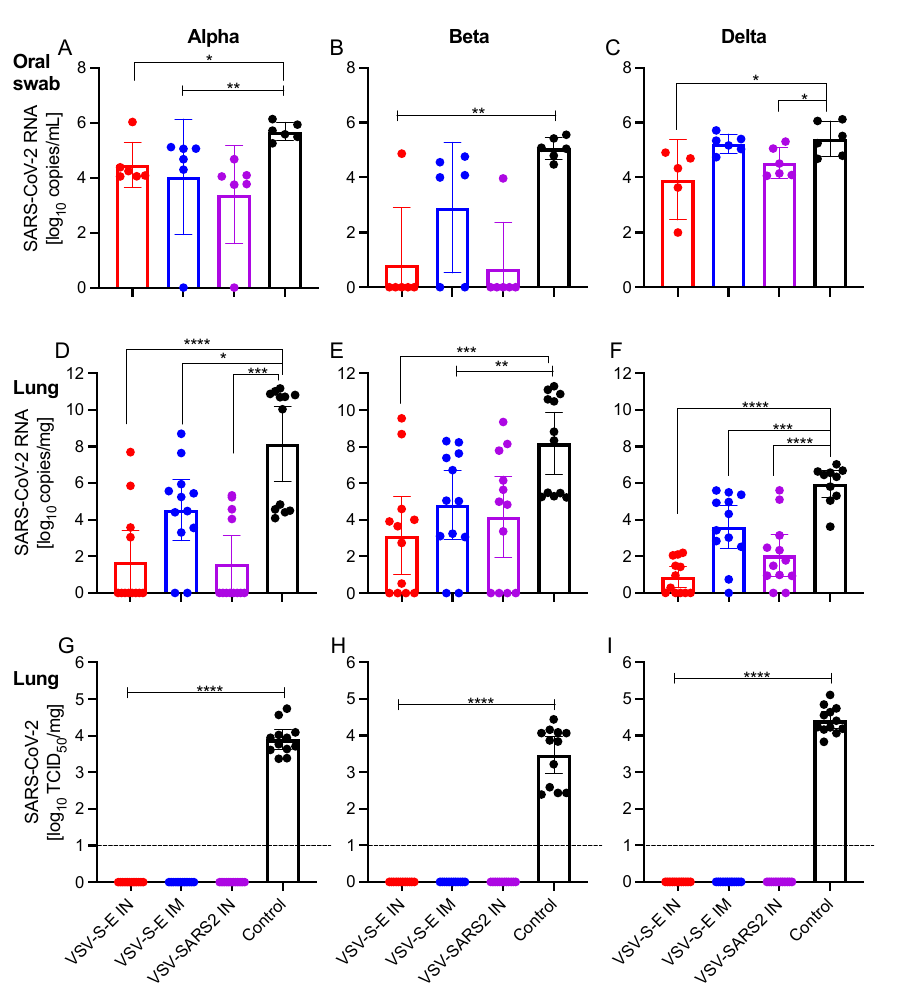
Figure 3. Vaccination reduces viral burden in hamsters. Hamsters were vaccinated IM or IN with VSV-SARS2-EBOV (VSV-S-E) or IN with VSV-SARS2 28 days prior to challenge with SARS-CoV-2 Alpha, Beta, or Delta VOC. At 4 DPC, oral swab and lung samples were collected. Levels of SARS-CoV-2 RNA in ( A – C ) oral swabs and ( D – F ) lung samples. ( G – I ) Virus titer in hamster lungs determined as median tissue culture infectious dose (TCID 50 ). Geometric mean and geometric SD are depicted. Statistical significance as determined by the Mann–Whitney test is indicated as p < 0.0001 (****), p < 0.001 (***), p < 0.01 (**), and p < 0.05 (*).